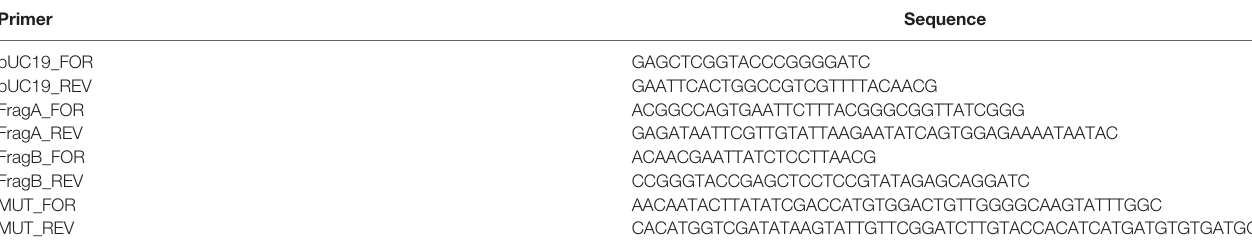
TABLE 1 | Sequences of primers used for PPAD T1/T2 mutants and a double PPAD-delFimA mutant construction.